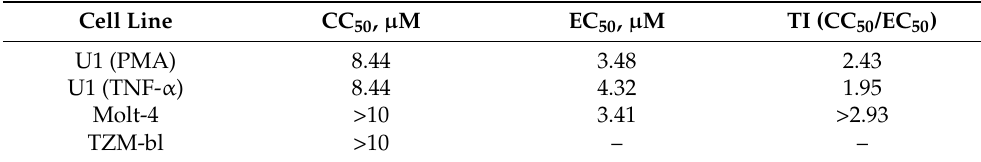
Figure 11. Structure of the anti-HIV pyranocoumarin GUT-70. Table 5. Antiviral activity and toxicity of GUT-70.